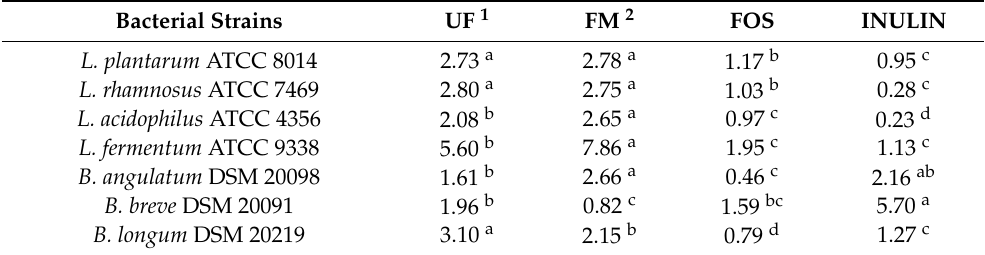
Table 8. The prebiotic indices of pre-fermented ingredients in UF and FM and commercial prebiotic products, FOS and inulin. For the same bacterial strains, average values lacking a common letter ( a–d ) significantly differ from each